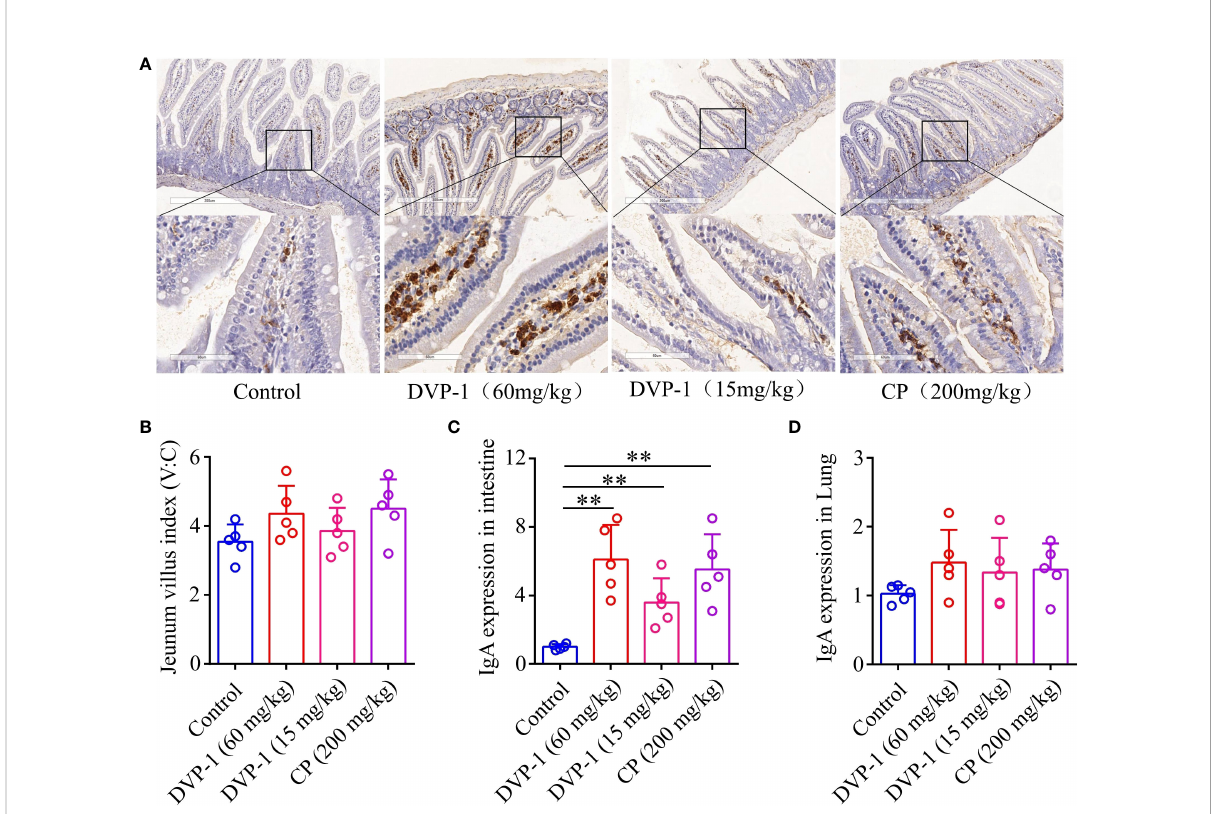
FIGURE 2 Mucosal immunohistochemistry experiment and real-time PCR. (A) , Immunohistochemical detection of IgA expression in jejunum mucosa (8×, 40×). (B) , Jejunum villi index. (C) , Real-time PCR to detect the expression of IgA in jejunum tissue. (D) , Real-time PCR to detect the expression of IgA in lung tissues. ** p <